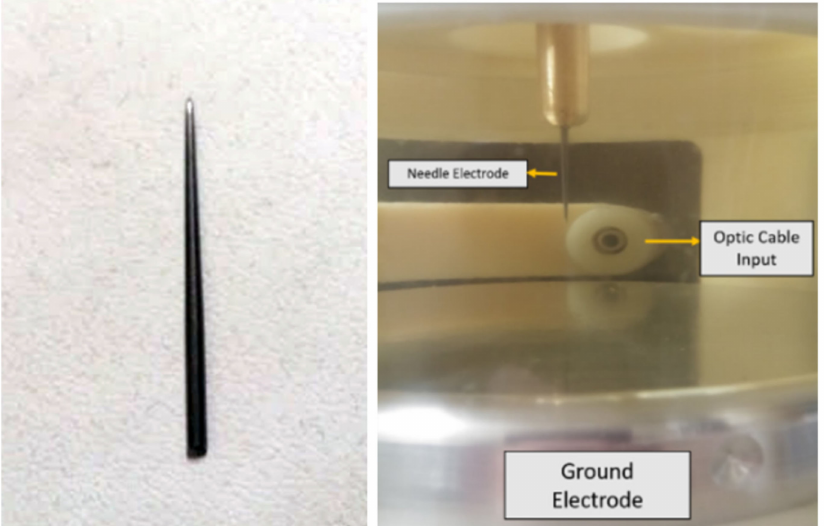
Figure 3. Actual view of needle electrode ( left ) and electrode setup placed inside the test cell ( right